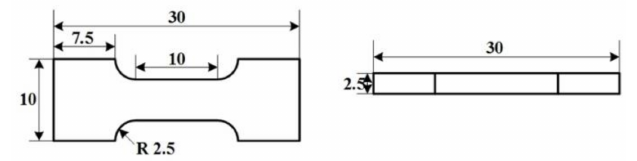
Figure 1. Dimensions of tensile sample